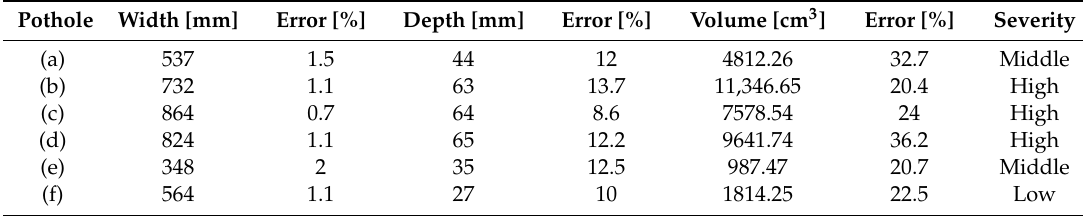
Table 8. Dimensions of potholes measured in model at 15 m and